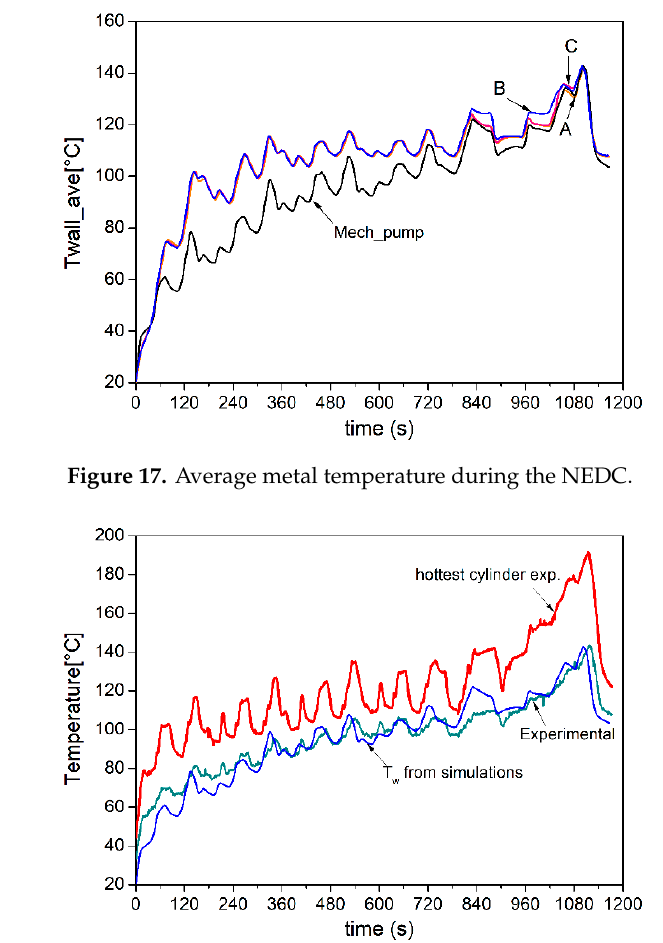
Figure 18. Simulated and measured metal temperatures during the NEDC cycle.